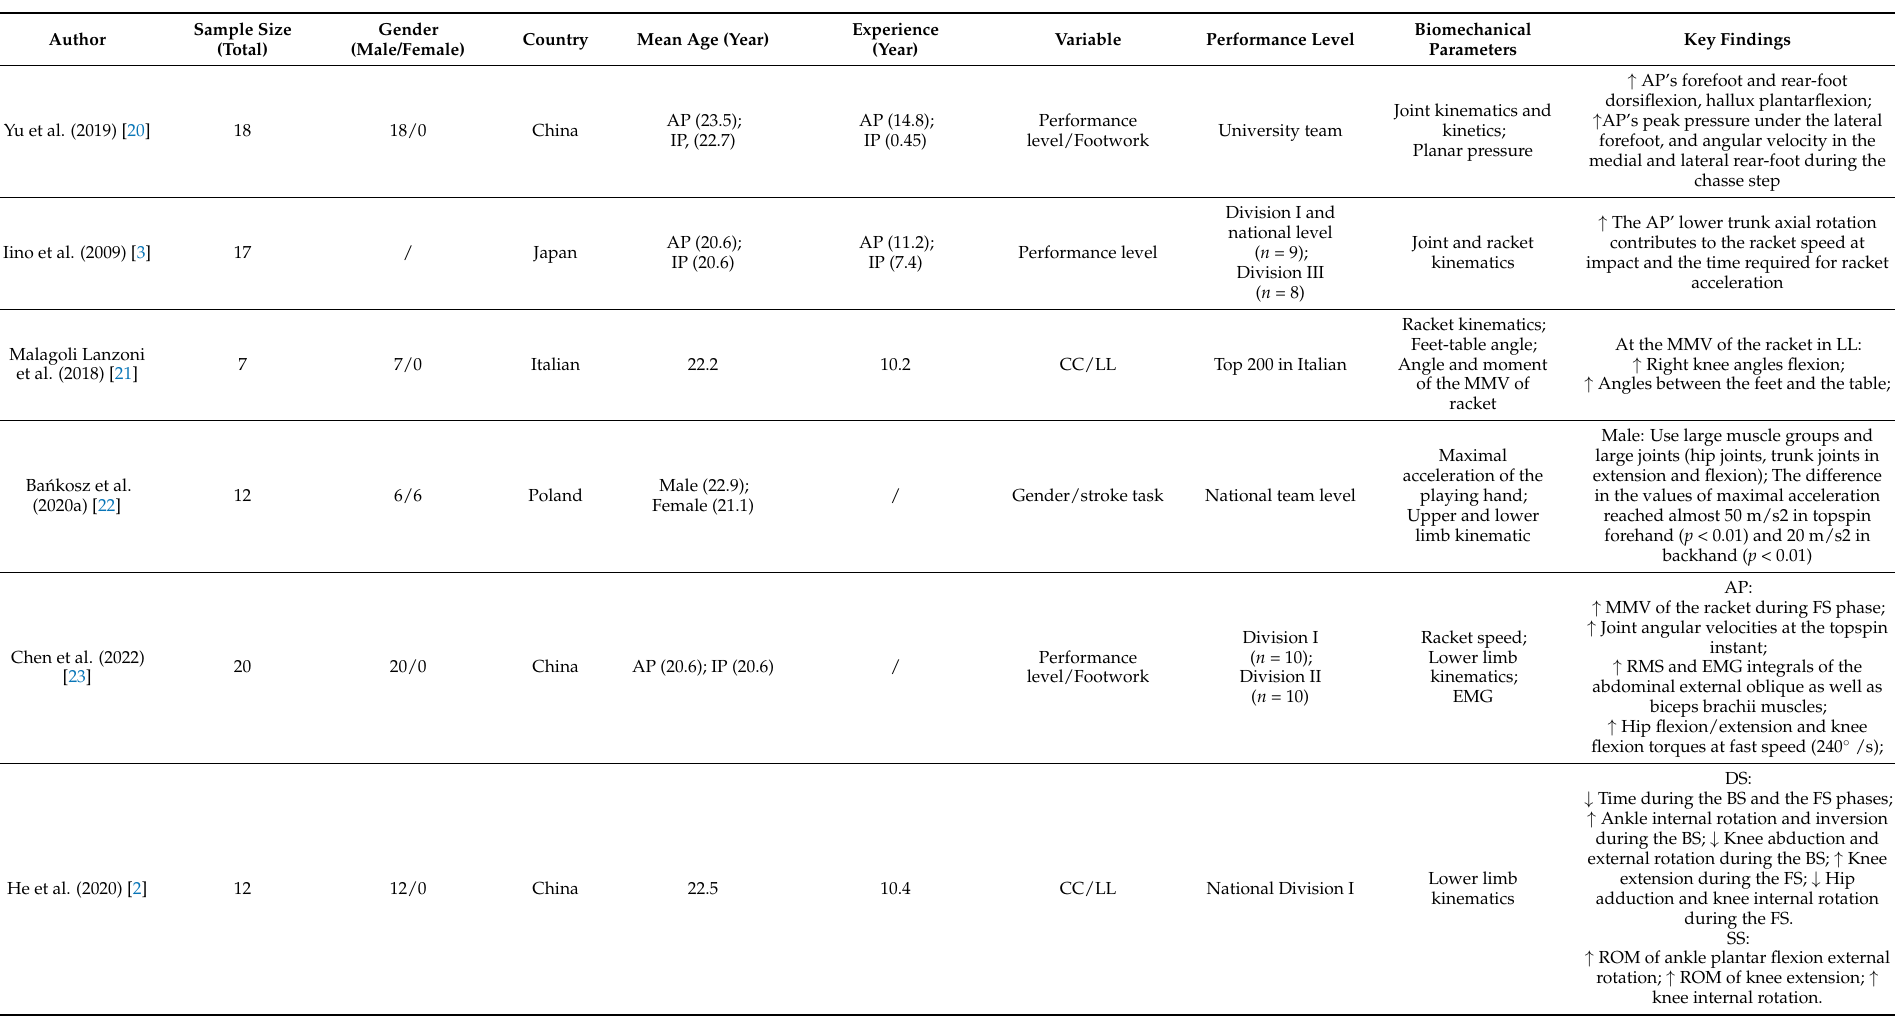
Table 2. The characteristic information of included